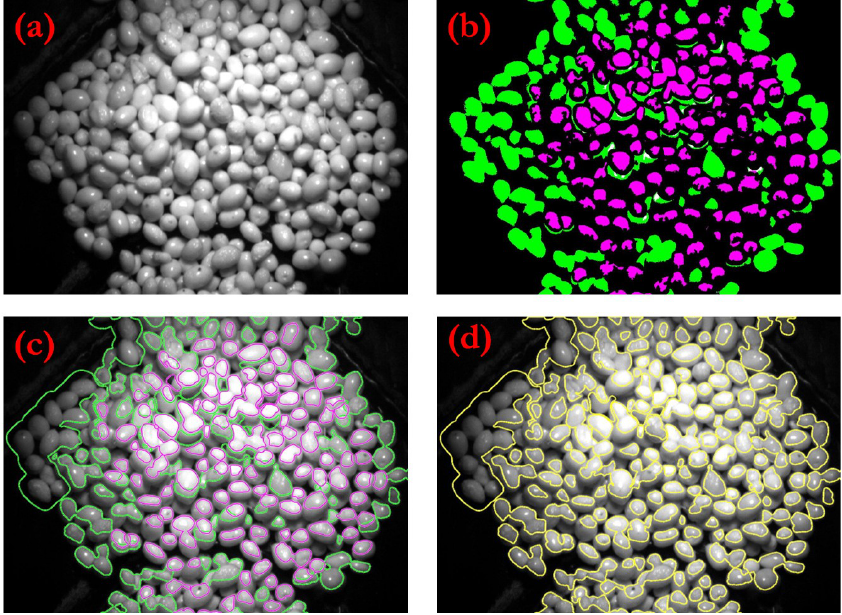
Figure 8. Example of olive segmentation (conveyor belt completely full). ( a ) Image acquisition. ( b ) Re- sult of the preprocesing step: global thresholding mask in magenta and adaptative thresholding mask in green. ( c ) Level one (magenta) and level two (green) segmentation. ( d ) Final segmentation